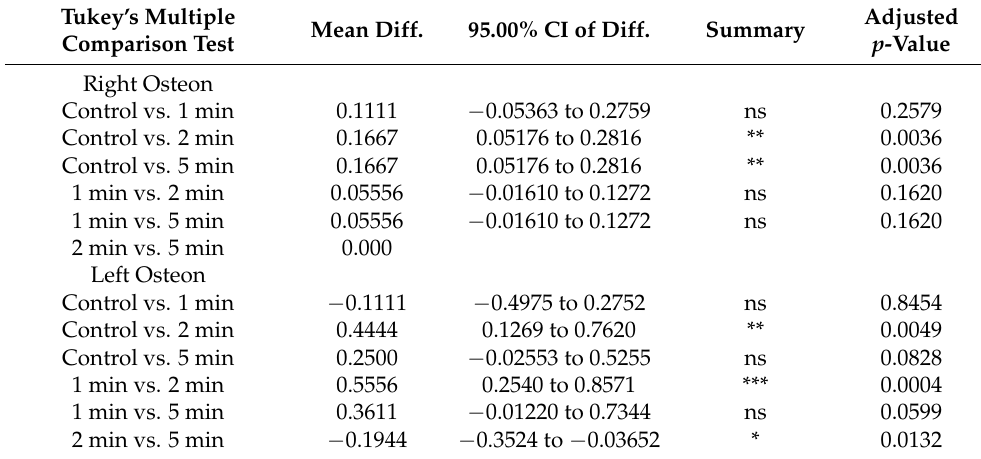
Table 5. Osteon table of the left and right tibia.